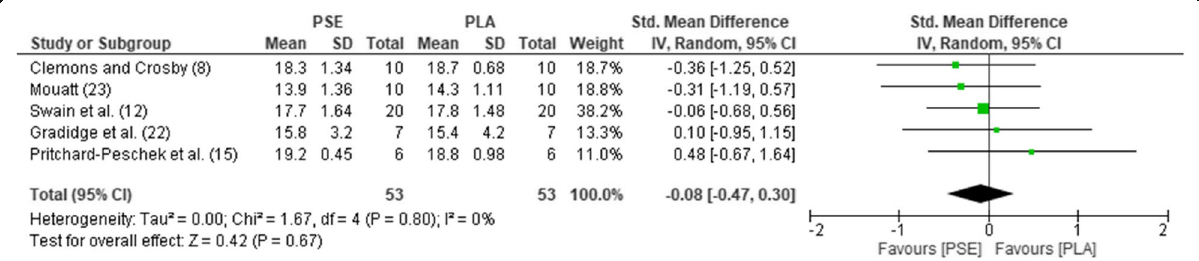
Fig. 4 Forest plot for effects of PSE on RPE with 95% confidence intervals. RPE, rating of perceived exertion; PSE, pseudoephedrine; PLA, placebo; SD, standard deviation; Std., standardised; IV, instrumental variables; CI, confidence interval. Positive effect sizes represent an increased RPE due to